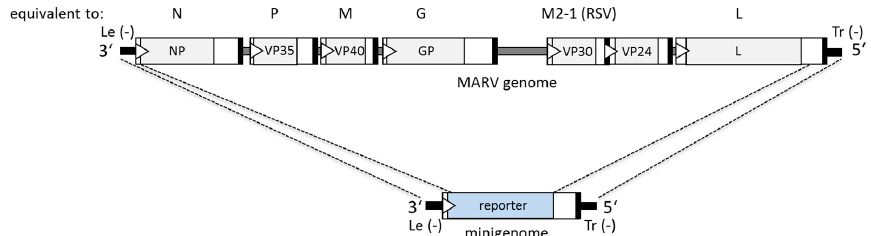
Figure 1. Scheme of the Marburg virus (MARV) genome ( top ) and the minigenome ( bottom ) in negative ‐ sense orientation. Coding regions of the seven MARV genes are shown as grey boxes in the genome. The homologous proteins of other nonsegmented negative ‐ sense (NNS) RNA viruses are indicated above the genome. In the minigenome, the viral genes are replaced by a single reporter gene, which is flanked by the MARV leader and trailer regions, the nontranslated region of the nucleoprotein ( NP ) gene containing the gene start (GS) signal, and the nontranslated region of the large protein ( L ) gene containing the gene end (GE) signal. Black lines, leader and trailer regions; gray lines, intergenic regions; white bars, nontranslated regions; white arrow heads, GS signals; black bars, GE signals; blue box, reporter